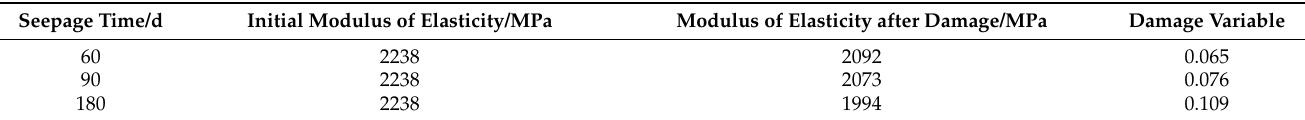
Table 3. The damage variables are calculated according to the elastic